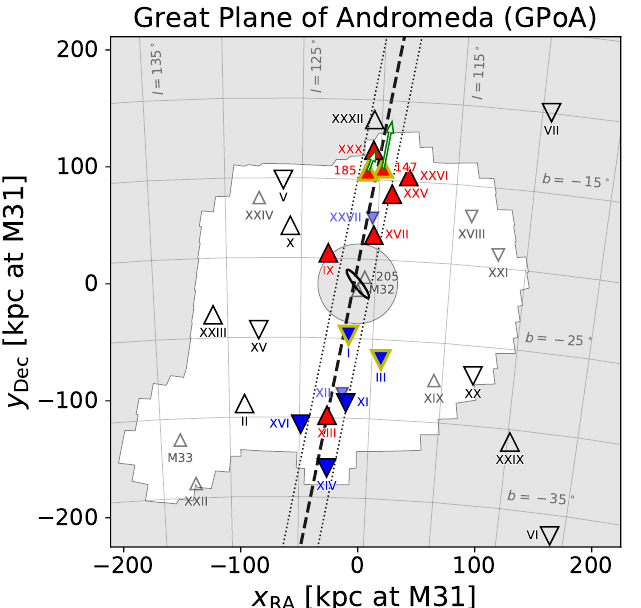
Figure 4. Distribution of dwarf galaxies around M31, as seen from our position. The shaded regions indicate the PAndAS survey footprint, within which most M31 satellite galaxies have been discovered. The position and orientation of M31 itself is indicated with the black ellipse in the center. The GPoA is seen edge-on and is indicated with a dashed line, while the dotted lines give its root mean square width. The symbols indicate whether a dwarf galaxy is approaching (downward pointing triangle) or receding (upward pointing triangle) from us relative to M31’s systemic velocity. The on-plane satellites are also color-coded as in Figure 2. Smaller, fainter symbols indicate that a dwarf lies behind M31, while larger, brighter symbols indicate the dwarf is in front of M31. This illustrates the strong lopsidedness of the M31 dwarf galaxy system, with the majority of satellites—and almost all GPoA members—residing in front of the galaxy as seen from the Milky Way. The two proposed pairs of satellites, NGC147 and NGC185 in the North, and AndromedaI and AndromedaIII in the South, are highlighted by yellow outlines. Both pairs are part of the GPoA. The green arrows indicate the most likely velocity of NGC147 and NGC185, based on their proper motion, and show that these two dwarfs are consistent with co-orbiting along the GPoA in the sense indicated by the GPoA’s line-of-sight velocity trend, but they differ enough in their velocities to not constitute a bound pair